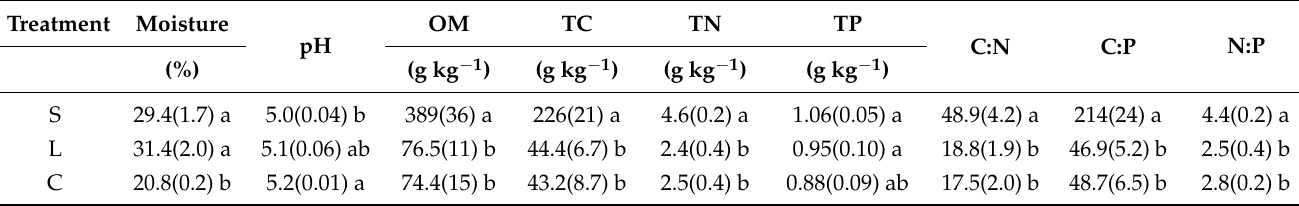
Values [means (SE), n = 4] followed by different letters are significantly different at p < 0.05 (ANOVA, Tukey HSD). Abbreviations: C = Control forest soil with no influence from mushroom cultivation; C:N, the ratio of total carbon to nitrogen; C:P, the ratio of total carbon to phosphorous; L = soil forest from furrows with low influence by mushroom cultivation; N:P, the ratio of total nitrogen to phosphorous; OM, organic matter; S = forest soil below fungal beds strongly influenced by mushroom cultivation; TC, total carbon; TN, total nitrogen; TP, total